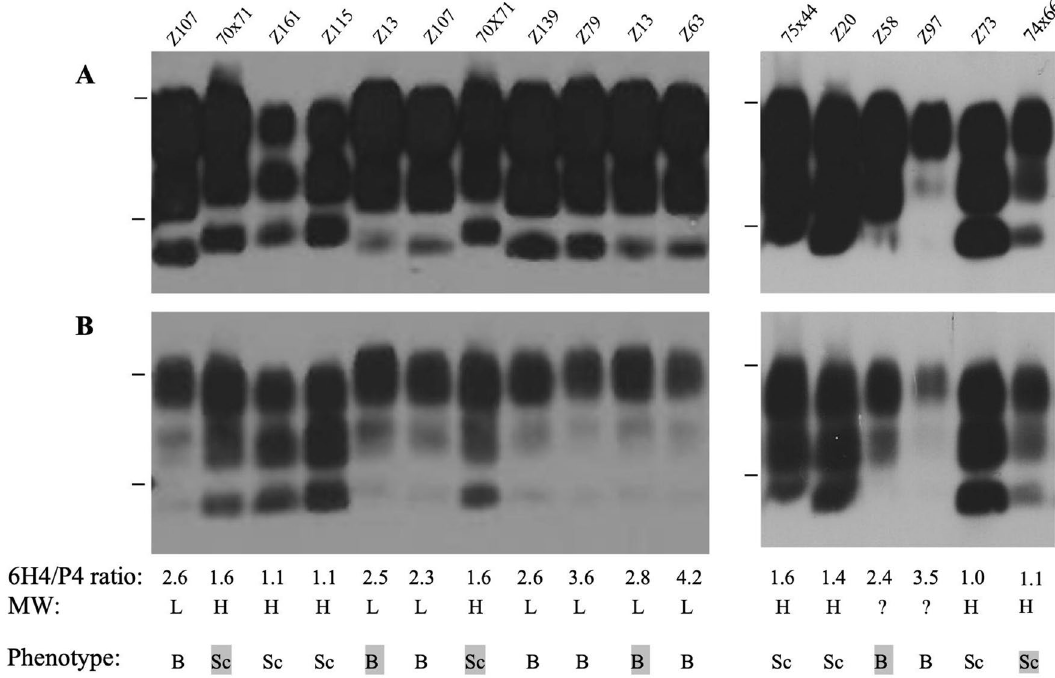
Figure 2. PrP Sc phenotype in sheep brain. Brain homogenates were digested with PK and analysed on western blots probed with 6H4 ( A ) or P4 ( B ). Representative blots are shown. Approximate molecular weight (MW) indicated at 30 kDa and 20 kDa. Individual sheep references (e.g. Z107 or 70 × 71 formats) are indicated. A relatively low MW for the unglycosylated PrP band with 6H4 staining or a relatively low P4 signal (a ratio of 6H4/P4 signal of > 2) indicated the PrP Sc had a BSE phenotype; strong P4 staining (a ratio of 6H4/P4 signal of 2 or less) and a relatively high MW unglycosylated band indicated a scrapie phenotype. These criteria and strain phenotypes are indicated. Shaded samples indicate sheep inoculated/infected with a single strain, all of these samples conformed to established molecular phenotypes of BSE or scrapie PrP Sc and so provided within-blot controls for these phenotypes. Where samples were subjected to repeat analysis, the assay gave consistent results (examples shown for Z107, 70 × 71 and and animals were culled with incubation time of 777 ± 50 days. In the group that received an inoculation of BSE at 21 m of age (NS + B21m, n = 9), incubation time was 803 ± 68 days. These incubation times are very similar to those of the control group showing no effect of the BSE super-infection (p = 0.69). Times of death following the BSE inoculation were 532 ± 53 days and 182 ± 68 days for NS + B8m and NS + B21m groups, respectively, and these times are likely to be too short to be BSE incubation periods or for the clinical signs to be the result of BSE rather than natural scrapie. We do not have data on subcutaneous inoculation of VRQ/VRQ sheep with BSE alone, however after intracerebral inoculation of VRQ/VRQ sheep with BSE, the average incubation period was > 1000 days 5 . Differential western blot analysis of PrP Sc in brain from inoculated sheep. The determination of the presence of BSE or scrapie-like PrP Sc in brain was carried out by western blot analysis of proteinase K (PK) digested samples (Fig. 2, Supplementary Fig. S1, Table 2 for individual animals). BSE can be distinguished from scrapie on western blot by the slightly lower molecular weight of the unglycosylated PrP Sc band (19 kDa vs 20 kDa). This reflects an altered PK cleavage site resulting in reduced staining by monoclonal antibody P4 in comparison to 6H4 in BSE samples, due to loss of the P4 epitope 39 . As expected, VRQ/ARQ sheep infected with SSBP/1 alone (n = 4) showed the typical scrapie-like PrP Sc western blot profile, whilst the two VRQ/ARQ sheep infected with BSE alone displayed the BSE western blot profile (n = 2). VRQ/ARQ sheep infected with S/B or S + B3m (n = 10 in total) all produced a scrapie-like PrP Sc pattern on western blot, in agreement with their incubation periods, which were as expected for SSBP/1 in this genotype. Similarly, ARQ/ARQ sheep infected with SSBP/1 alone (n = 2) showed scrapie-like PrP Sc whereas those infected with BSE alone (n = 6) showed typi- cal BSE-like PrP Sc profiles. ARQ/ARQ sheep infected with S/B (n = 8) showed PrP Sc patterns that were BSE-like, again in accordance with the incubation period data, which was typical of ARQ/ARQ sheep infected with BSE rather than SSBP/1. Six out of eight ARQ/ARQ sheep infected with S + B3m, gave a BSE-like PrP Sc pattern on western blot. However, in two animals (Z73 and Z115) with the LF 141 genotype, western blotting of PrP Sc gave a scrapie-like signature. In the natural scrapie sheep groups (n = 9), the PrP Sc profile on western blot were all indicative of scrapie, regardless of whether or not they were also challenged with BSE.